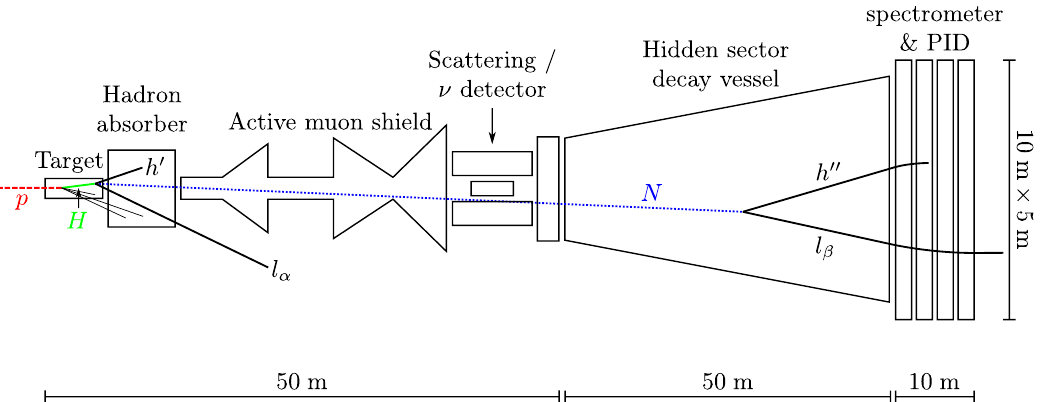
Figure 1. Sketch of the SHiP experiment, with the decay chain H ! h for baryogenesis [10, 38] and especially for late-time leptogenesis [39]. Quasi-Dirac